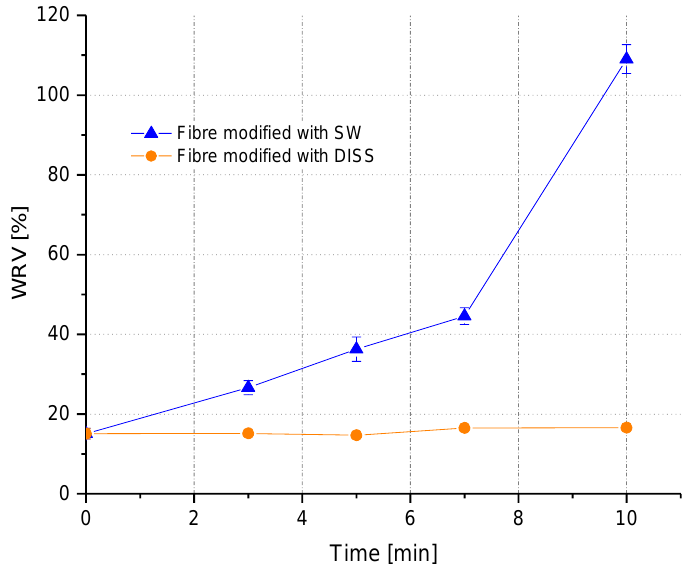
Figure 10. Water retention value vs time of treatment using DISS and SW.